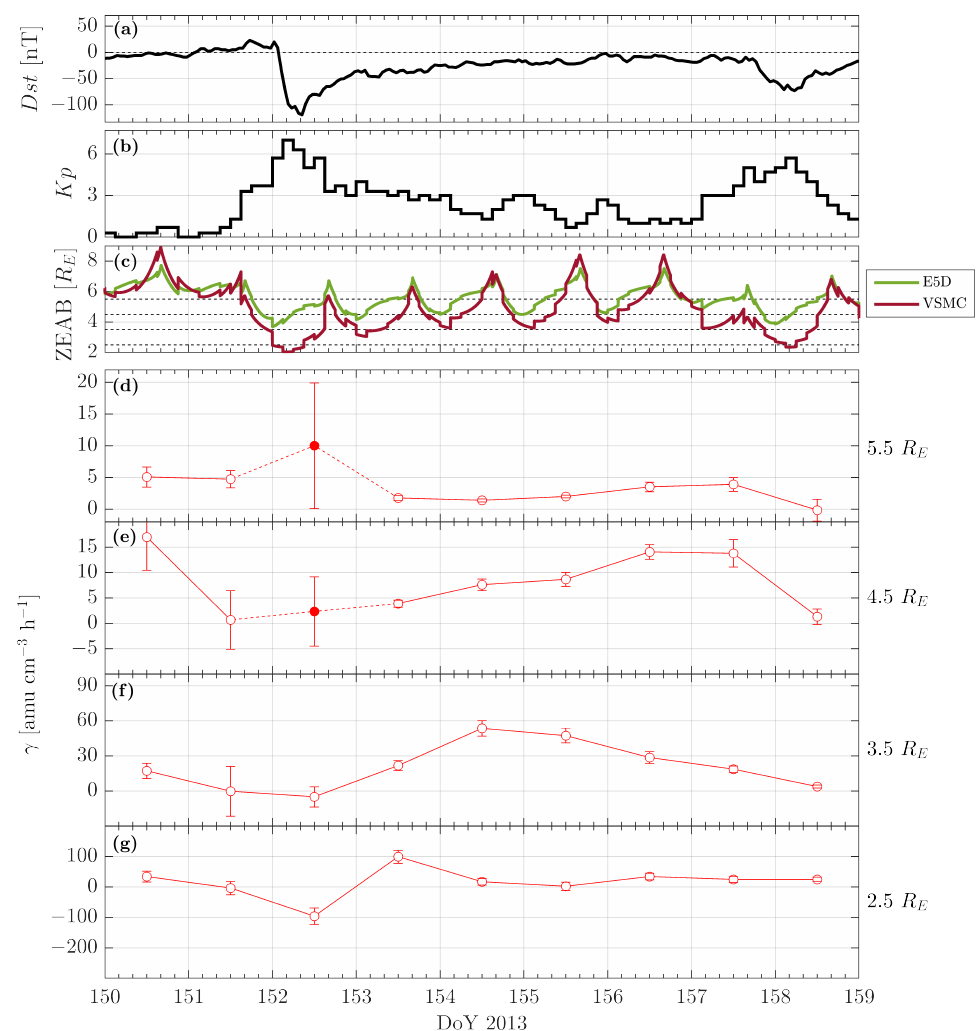
Figure 8. Panels ( d – g ) show the diurnal refilling rate for the same period and same geocentric distances shown in Figure 5. Panels ( a – c ) are the same as in Figure